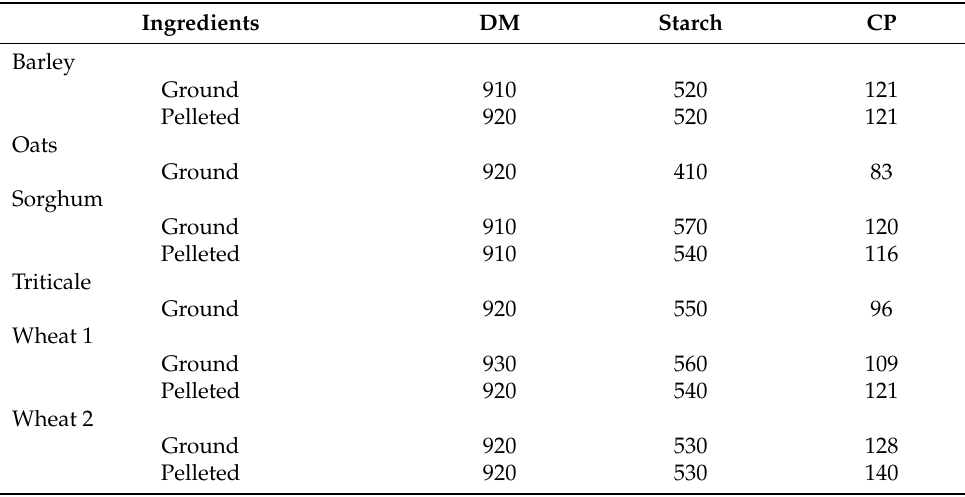
Table 1. Chemical composition (g/kg) of